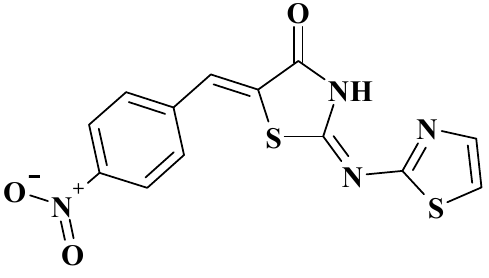
Figure 1. Chemical structure of compound Les-6222.